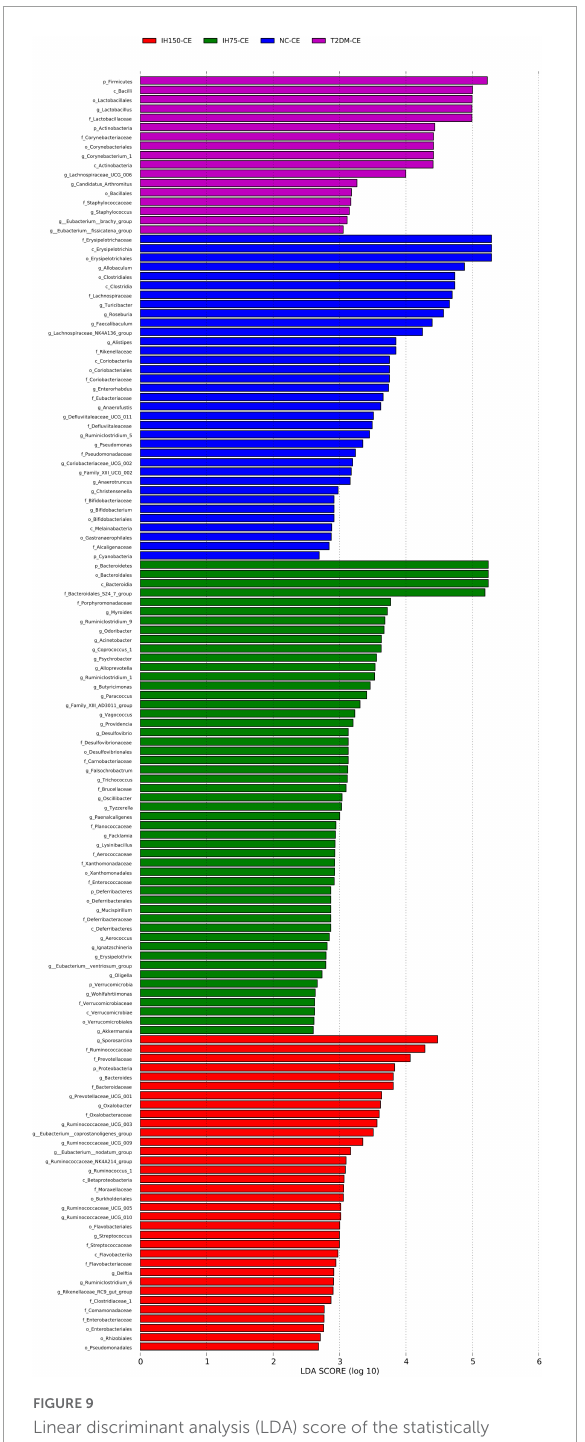
FIGURE9 Linear discriminant analysis (LDA) score of the statistically significant microbial groups in the two